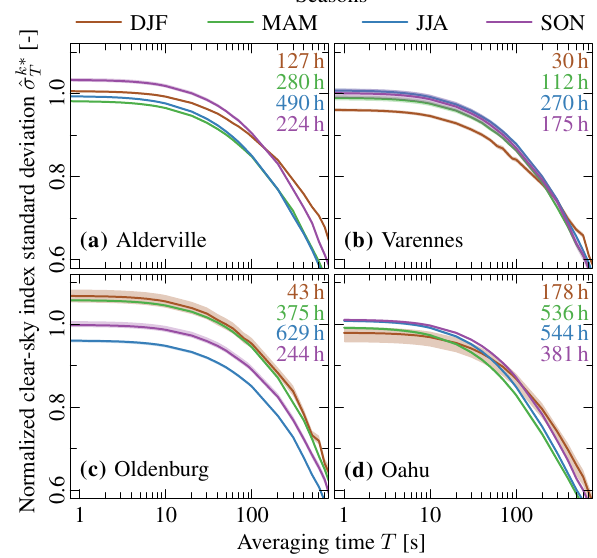
Figure 3. Structures of normalized clear-sky index standard de- ∗ Figure 4. As in Fig. 3, for structures separately estimated for winter T under mixed-sky viation ˆ σ k T as a function of averaging time (December, January, February; DJF), spring (March, April, May; conditions for all six available locations. The normalization factors MAM), summer (June, July, August; JJA), and autumn (September, ∗ σ k T = 1s are quoted for each location. The spread across multiple in- October, November; SON). The respective durations of available dividual single-sensor structures is indicated using semi-transparent mixed-sky data are quoted in the appropriate color for each sea- coloring, while the solid lines are derived by averaging the single- son and location. The normalization factors are the location-specific sensor structures for each T . ∗ standard deviations σ k T = 1s derived without conditioning by season (Fig. 3). The spread across individual single-sensor structures is in- dicated using semi-transparent coloring, while the solid lines are derived by averaging the single-sensor structures for each T